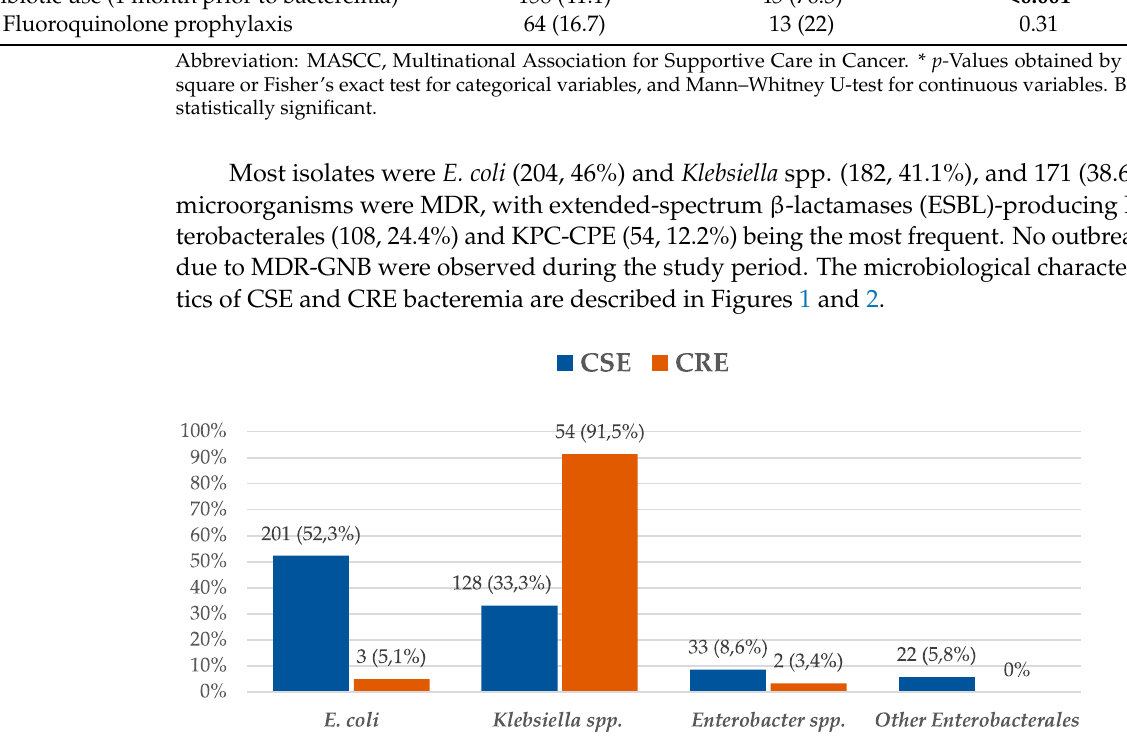
Figure 1. Etiology of Enterobacterales bacteremia. Differences between carbapenem-susceptible Enterobacterales (CSE) and carbapenem-resistant Enterobacterales (CRE) isolates.